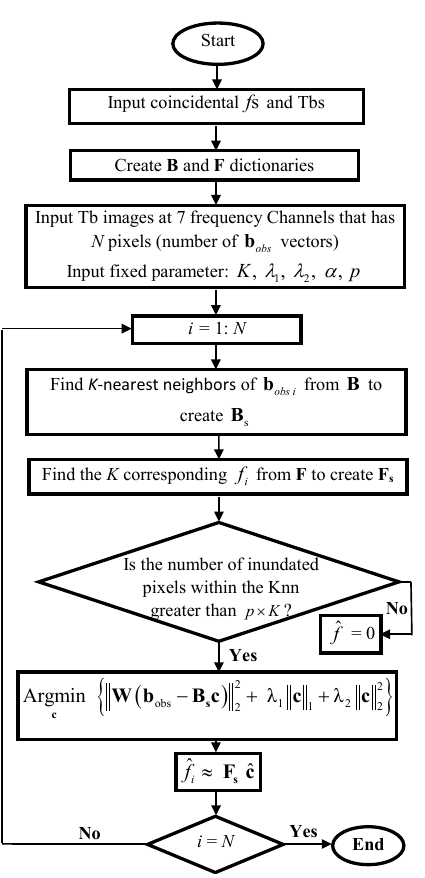
Figure 3. Flowchart of the inundation retrieval algorithm for N pix- els in each orbit, where Knn stands for the K -nearest neighbor. See text for definitions of the notations and detailed